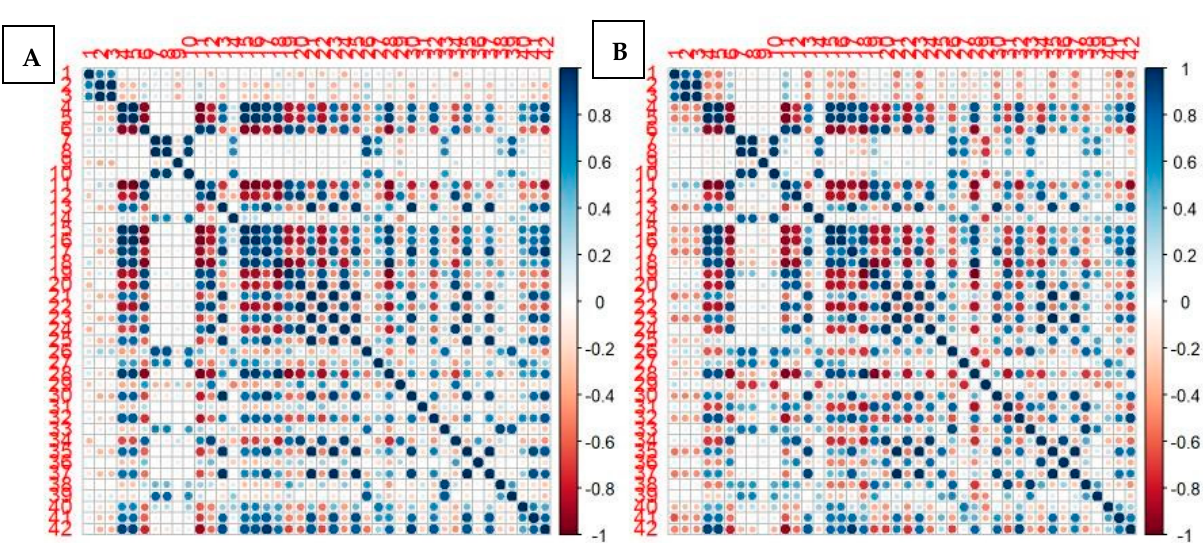
Figure 4. Correlation map for all first-order and second-order radiomics features between the two scanners (scanner DSTE ( A ); scanner 690 ( B )). Red means high positive correlation; blue means high negative correlation; white means no correlation.